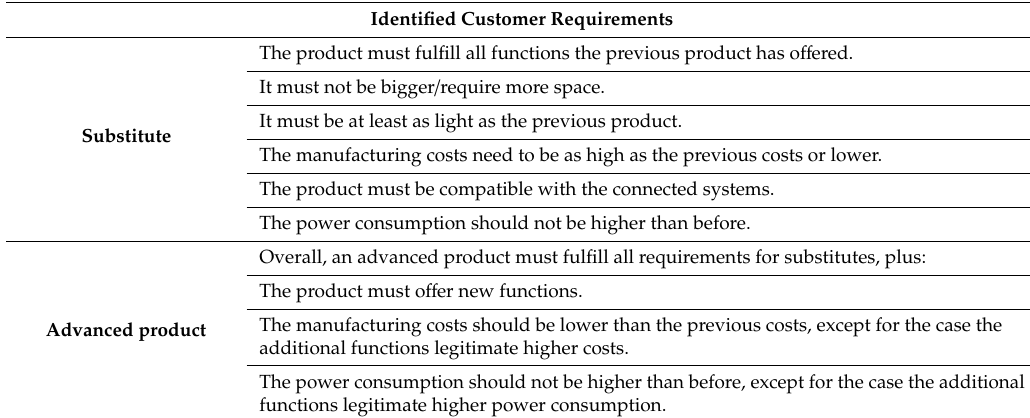
Table 2. Identified customer requirements for SMA-based actuators in aircraft